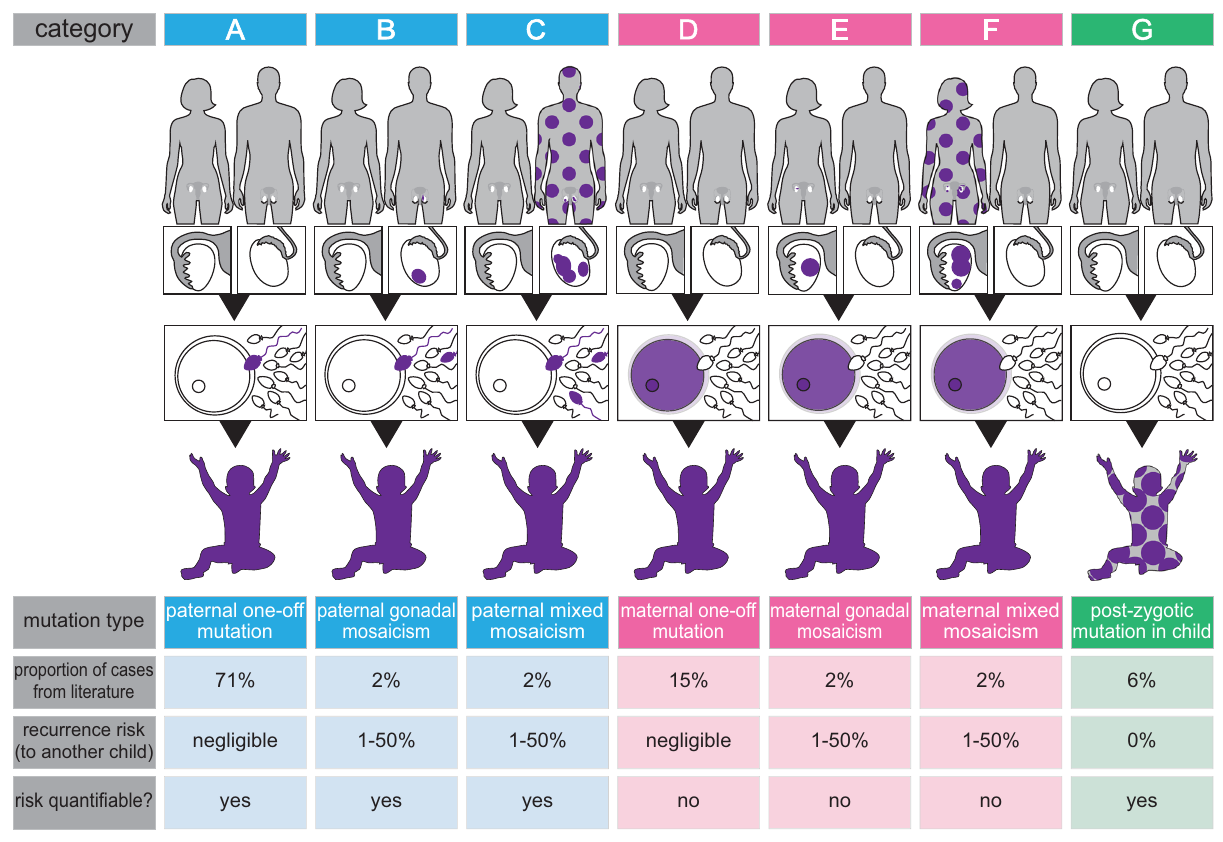
Fig. 1 | Strati fi cation of DNMs into seven categories. Establishing the origin (paternal [blue], maternal [pink] or post-zygotic [proband, green]), and timing of themutationalevents(purplecolourindicatesmutantcells),yieldswidelydifferent